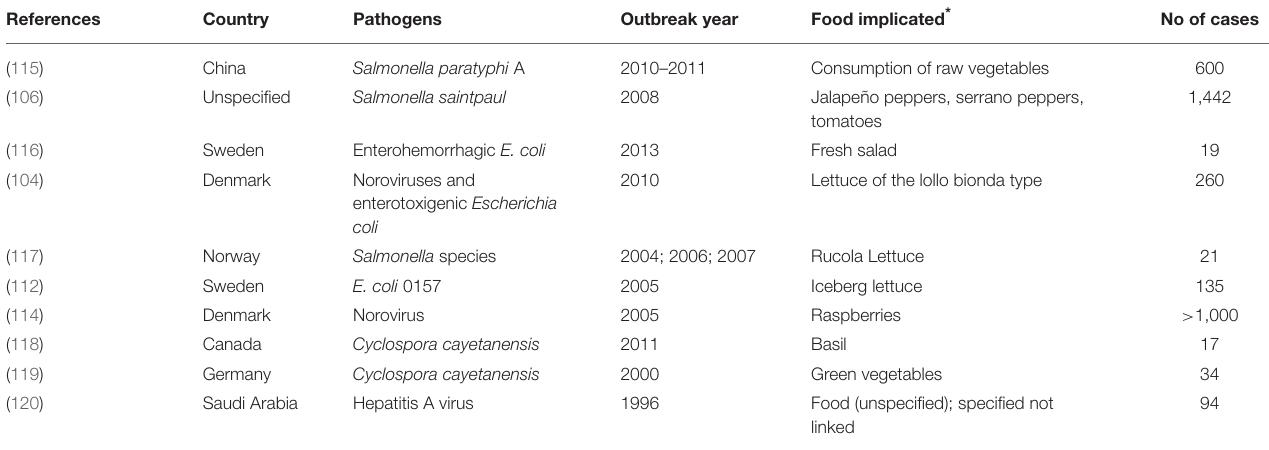
TABLE 3 | Examples of food-borne outbreaks (human) associated with the consumption of fresh produce irrigated with wastewater from selected literature (Only the reports with year of outbreak, food implicated and number of cases were